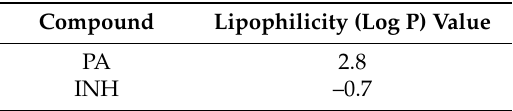
Table 2. Determination of lipophilicity of PA and